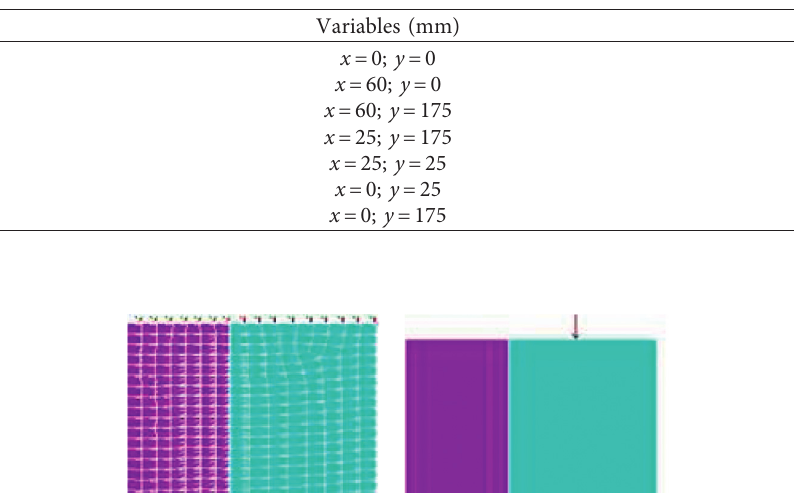
Table 5: Boundary conditions for the applied pressure of 130MPa.